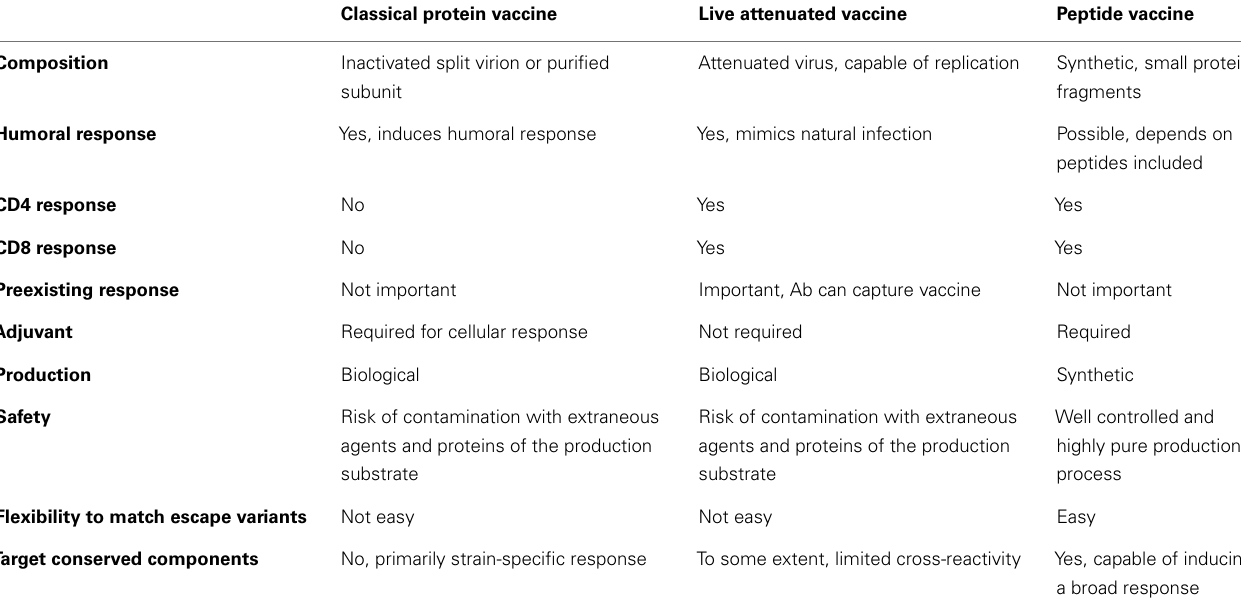
Table 1 | Comparison of classical protein vaccination, live attenuated vaccination, and peptide